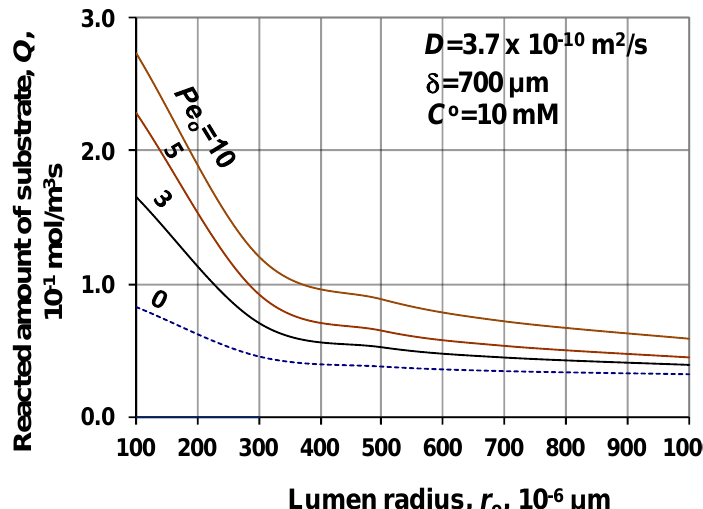
Figure 10. Inlet mass transfer rate and the conversion as a function of the lumen radius, at different values of the membrane Pe o -number. ( D = 3.7 × 10 –10 m 2 /s; δ = 700 μm; C O = 10 mM; N = 1000).